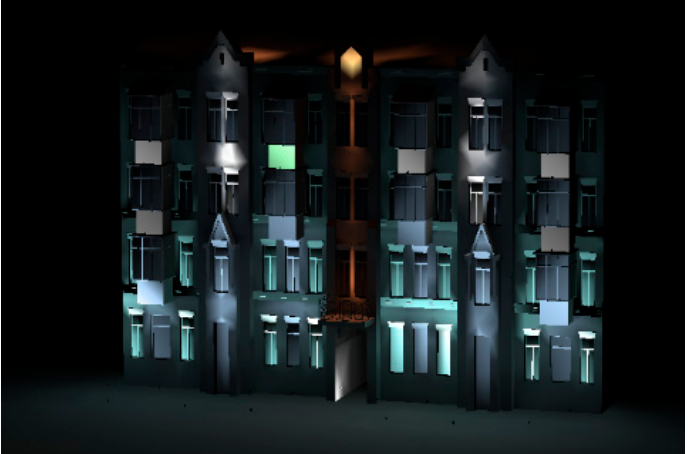
Figure 30. Fast communication of impressionism based on Monet’s painting “Impression”—Scene 5.